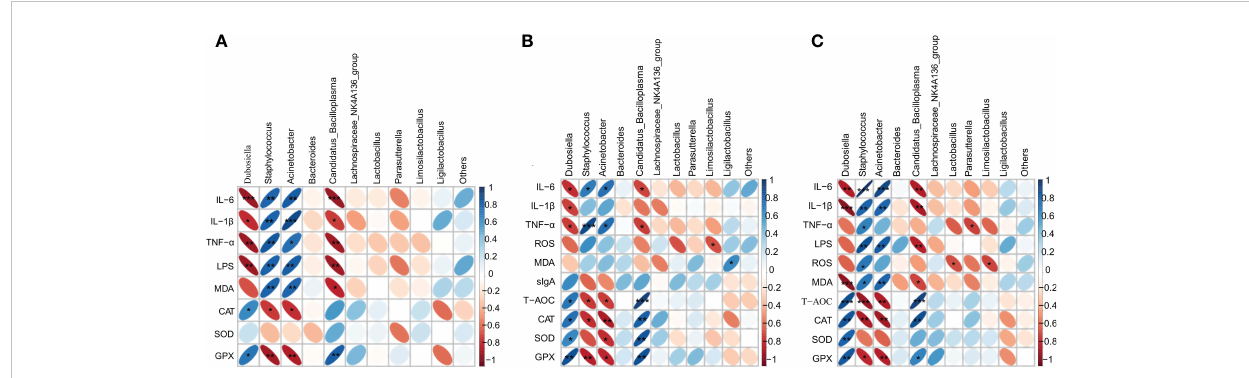
FIGURE 8 Heatmap showing the correlation of gut microbial genera with pro-in fl ammatory factors (IL-6, IL-1 b , TNF- a ), antioxidant enzymes (CAT, SOD, GPX), MDA, LPS, sIgA; (A) indicates correlation with serum; (B) indicates correlation with jejunum; (C) indicates correlation with liver. The colour and shape of the ellipse correlates with the strength of the correlation, with darker and fl atter ellipses being more strongly correlated (* p <0.05, ** p <0.01, *** p